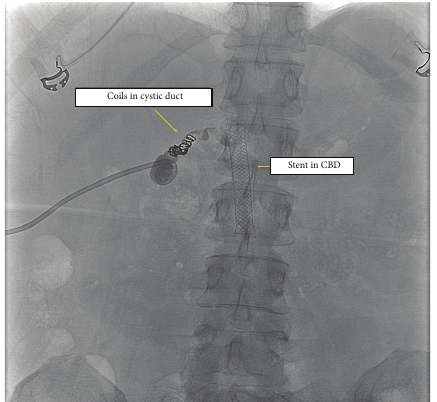
Figure 3: Coiling the cystic duct.